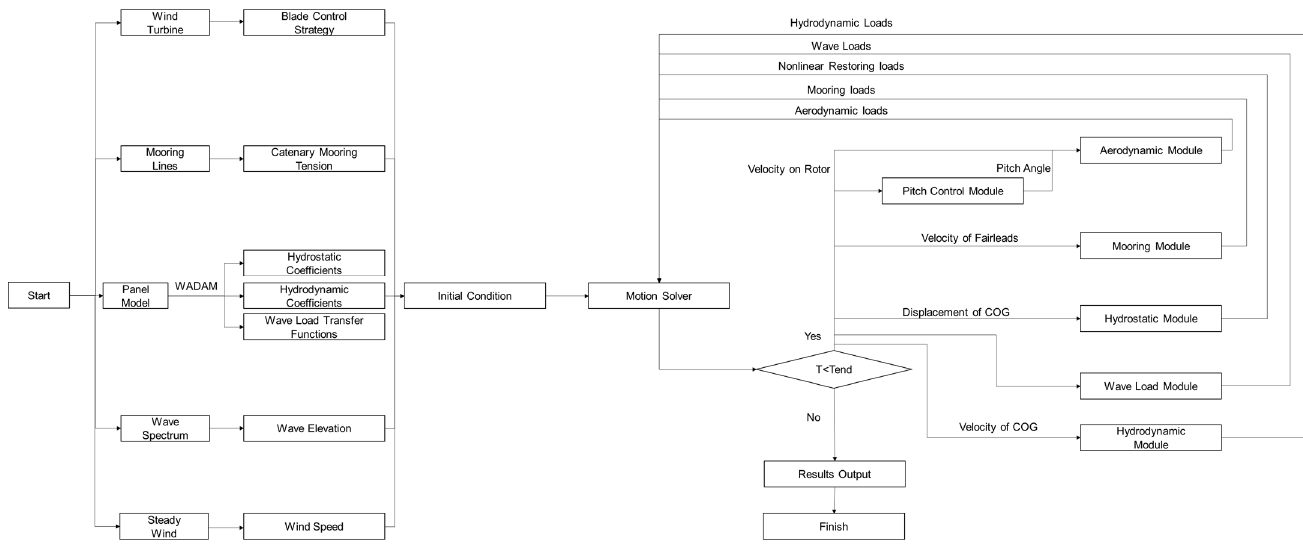
Figure 2. Flow chart of the numerical simulation tool.